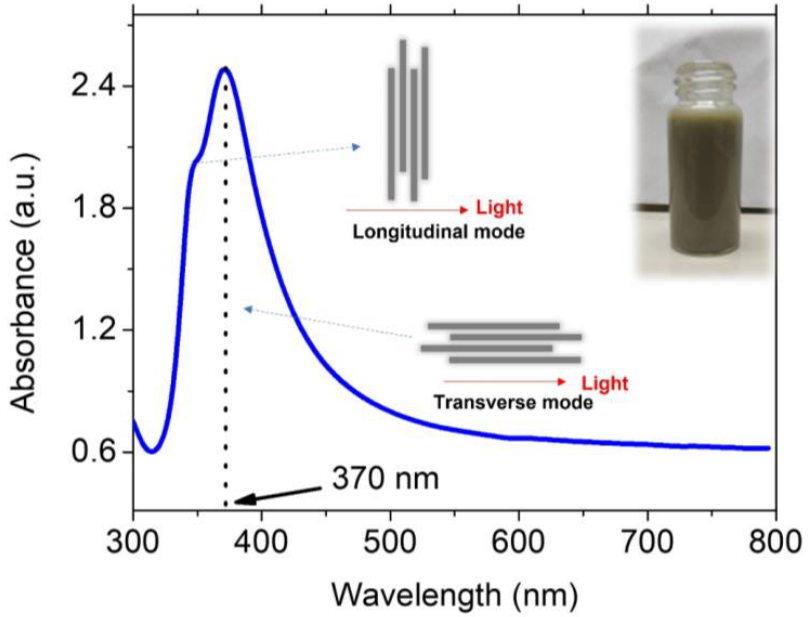
Figure 3. Electron micrograph showing ( a ) FESEM and ( b ) TEM images of AgNWs prepared using the modified polyol technique.